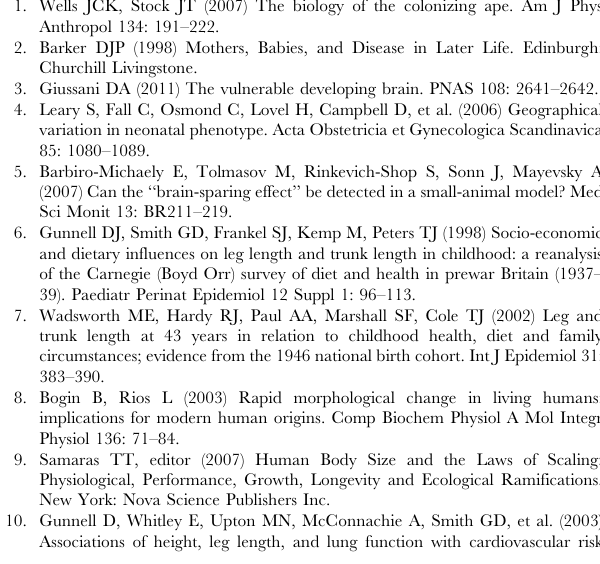
Table S1 Summary statistics for anthropometric variables age group for lowland (L, n =247) and highland (H, n= 200) children. Data presented as ‘mean (standard deviation)’, n presented as ‘lowland, highland’. Table S2 Differences between populations (lowland-highland) in mean raw measurements by age group. Standard error of the difference given in brackets. Table S3 Percentage differences between populations (lowland- highland) in mean raw measurements by age group. Table S4 Differences between populations (lowland-highland) in mean z scores by age group. Standard error of the difference given in